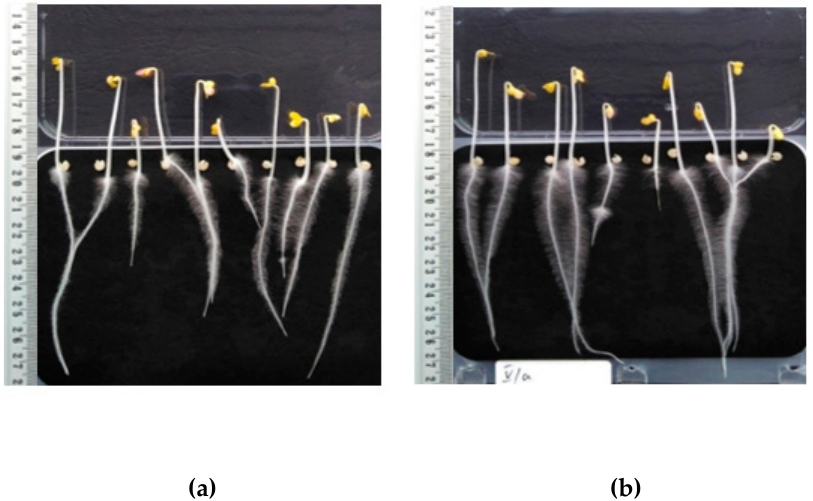
root parts and a greater number of developed shoots of the Sorghum saccharatum plant are Figure 4. Sinapis alba after three days of incubation: (a) Untreated sample, ( b) HS fertilization. Figure 4. Sinapis alba after three days of incubation: ( a ) Untreated sample, ( b ) HS fertilization.